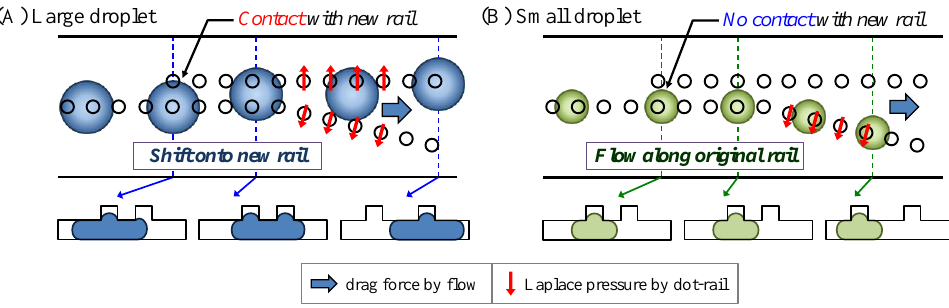
Figure 1. The principle of a size-dependent droplet sorting by selective droplet transfer on dot-rail. ( A ) Transferring of large droplets; ( B ) Guiding of small